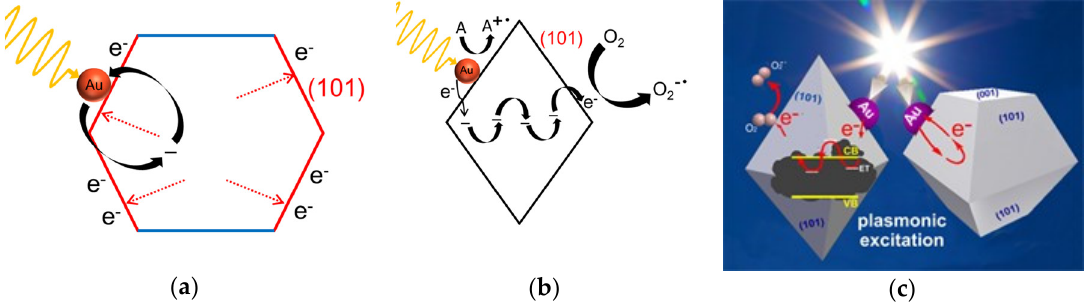
Figure 1. The mechanism of possible “hot” electron transfer on Au-modified: ( a ) decahedral anatase particles (DAP), ( b ) octahedral anatase particles (OAP), and ( c ) DAP vs. OAP; adapted with